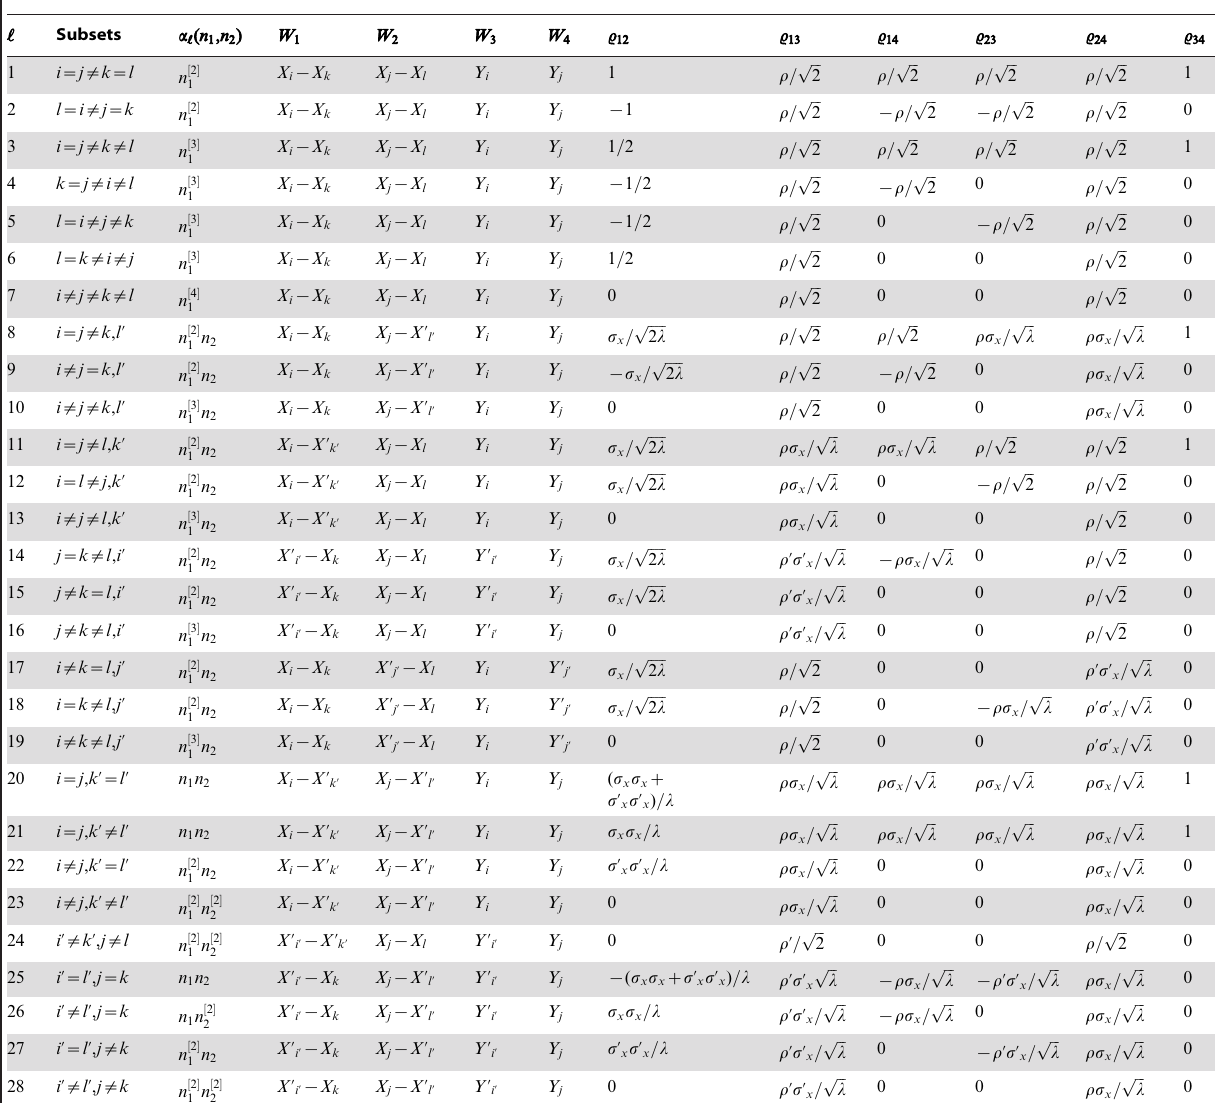
E f H ( X { X { X i k ) H ( X j l ) Y i Y j g in Eq. i , j , k , l